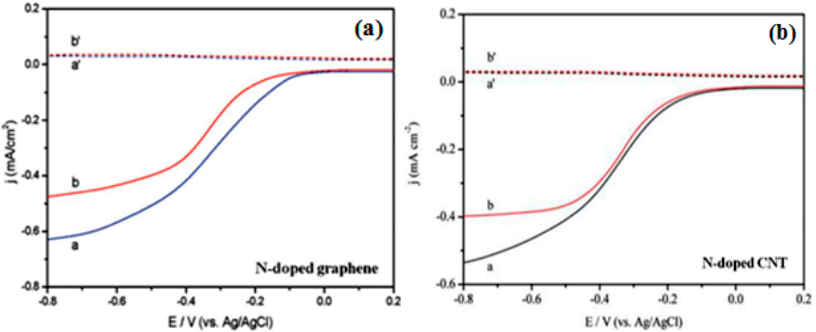
Figure 6. ( a ) Rotating ring-disk electrode (RRDE) voltammograms and the corresponding amperometric responses for oxygen reduction in air-saturated 0.1 M KOH at the CNT/GC (curves 1 and 1 ′ ), Pt-C/GC (curves 2 and 2 ′ ), and N-doped CNT/GC (curves 3 and 3 ′ ) electrodes at a scan rate of 10 mV/s. The electrode rotation rate was 1400 rpm, and the Pt ring electrode was poised at 0.5 V; ( b ) Calculated charge density distribution of the N-doped CNTs. (From [56]. Reprinted with permission from The American Association for the Advancement of Science).